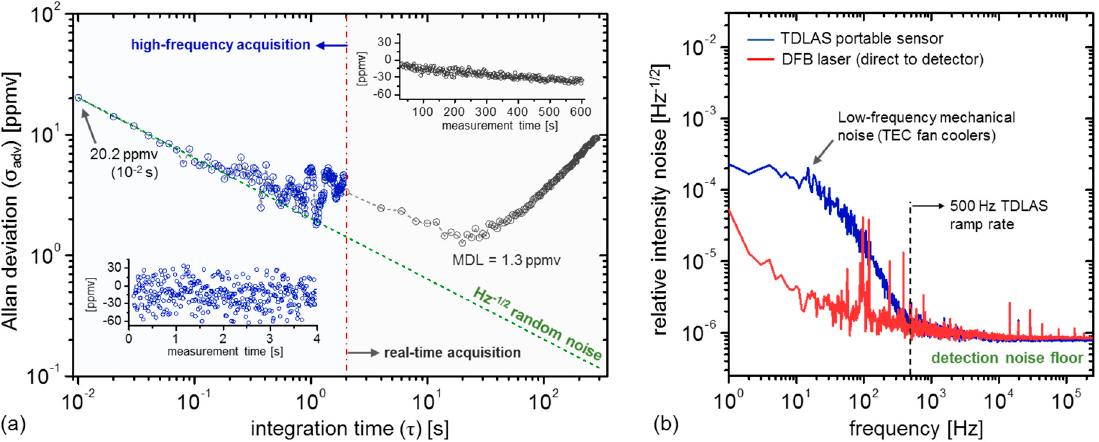
Figure 2. ( a ) Allan deviation analysis in two operating modes: (i) high-frequency acquisition (left, blue) and real-time acquisition (right, black), with CH 4 time-series shown in the insets. The TDLAS sensor demonstrates short-term sensitivity of 20.2 ppmv at 10 − 2 s (noise-equivalent absorption (NEA) = 4.5 × 10 − 6 Hz − 1 / 2 ), and a minimum detection limit (MDL) of 1.3 ppmv at 20 s. ( b ) The power normalized noise spectral density of the TDLAS sensor (blue), in comparison to the DFB laser source (red). The TDLAS line-scan frequency of 500 Hz is selected to mitigate the impact of low-frequency noise induced by the fan-cooled InGaAsP photodetectors.